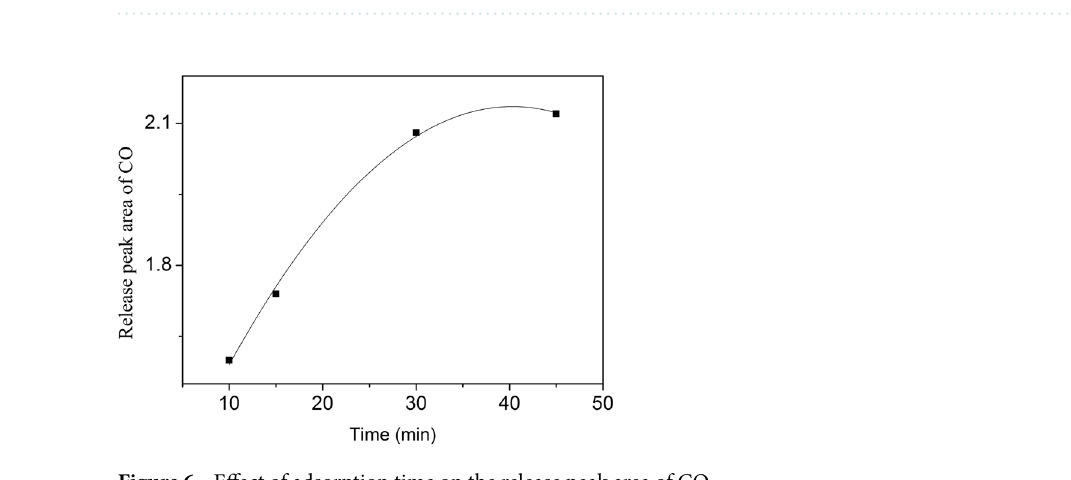
Figure 6. Effect of adsorption time on the release peak area of CO.